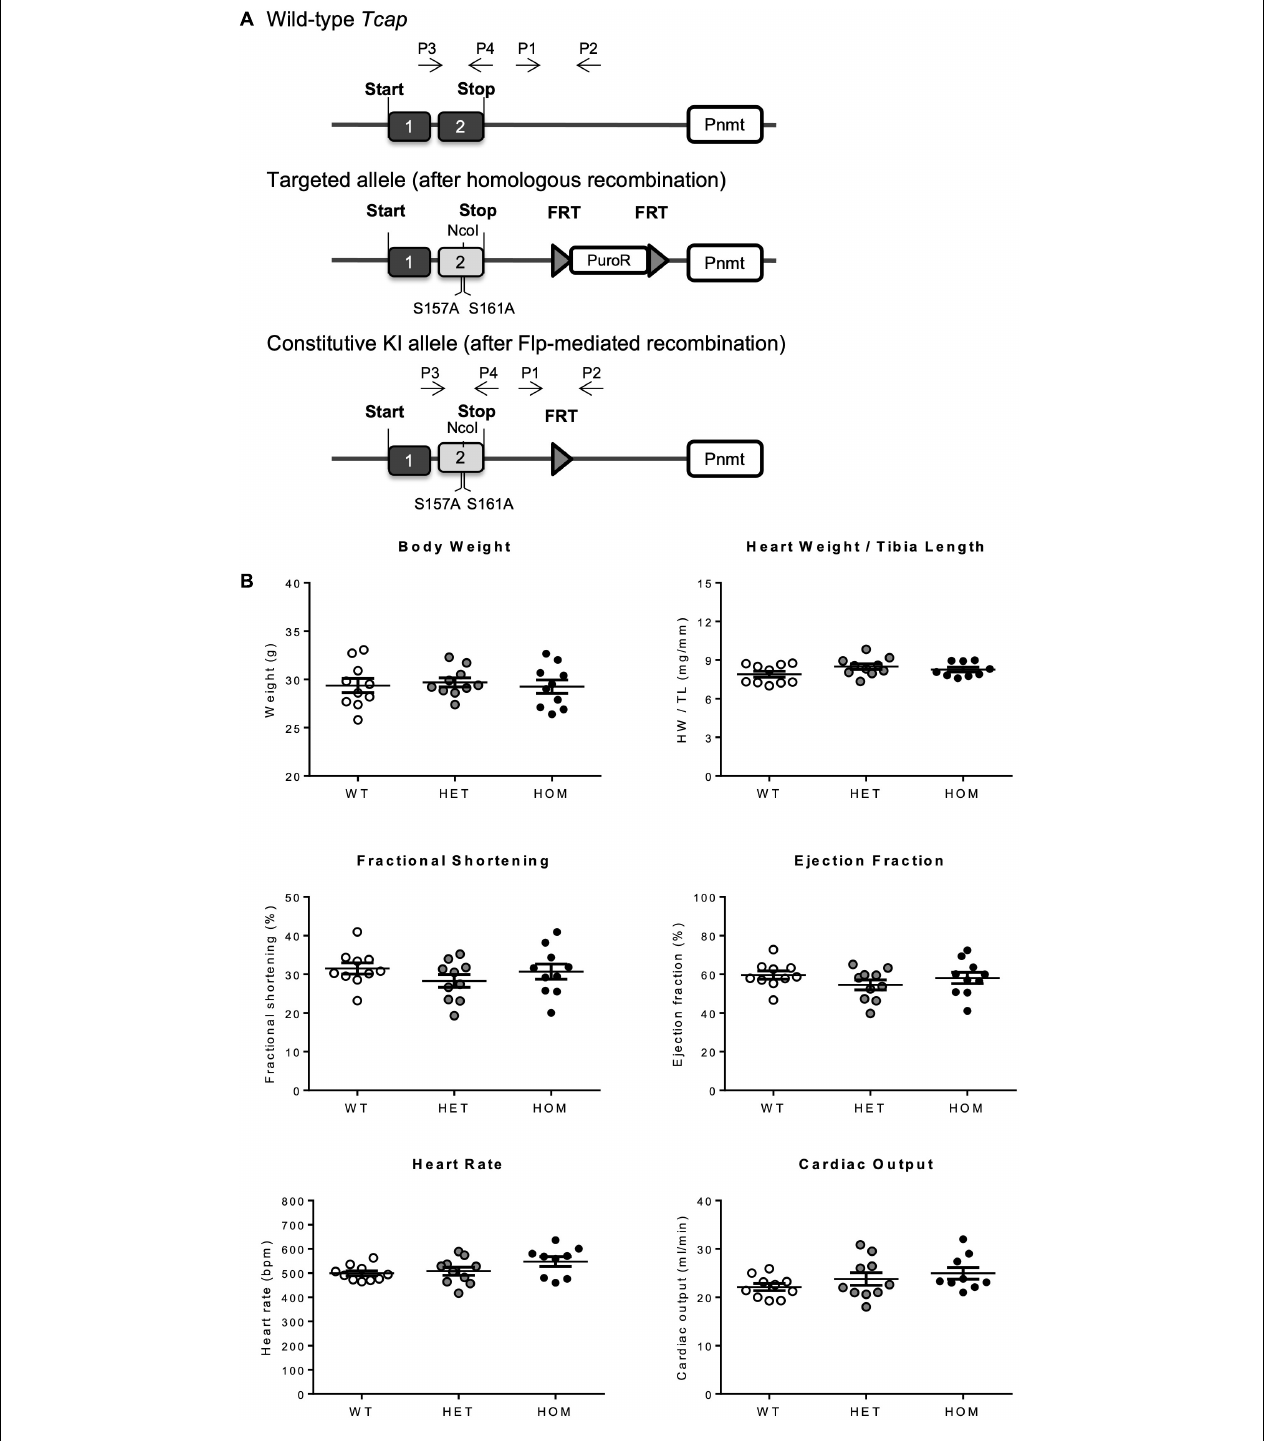
FIGURE 1 | Generation and characterization of the Tcap S157 / 161A KI mouse. (A) Schematic representation of recombination events, generating the Tcap S157 / 161A KI mouse. Targeted KI allele containing puromycin resistance selection cassette (PuroR) was generated after homologous recombination, and constitutive KI allele was generated after Flp -mediated recombination to remove PuroR. P1–4 indicates primer binding regions, 1 and 2 indicate exons 1 and 2 of Tcap gene. (B) Baseline phenotyping of male Tcap S157 / 161A KI mice. Gravimetric data from 16 week male mice including body weight and heart weight normalized to tibia length ( n = 9–10). Echocardiographic data from 16 week male mice showing fractional shortening, ejection fraction, heart rate, and cardiac output ( n = 9–10). Data expressed as mean ± SEM, one-way ANOVA with Tukey’s post hoc test.